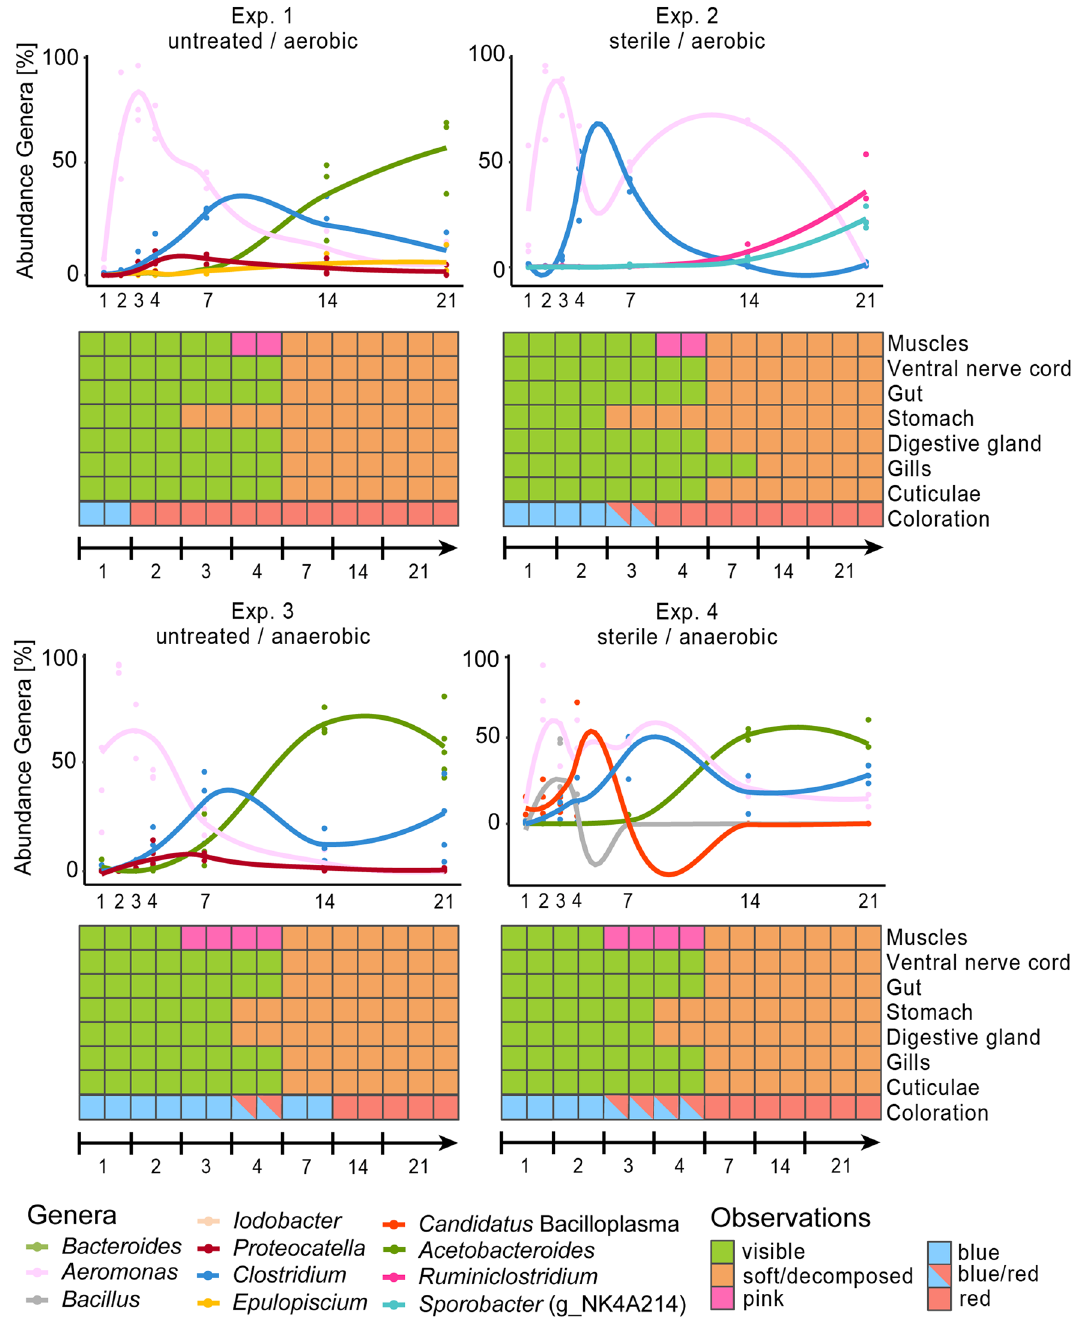
Figure 2. Time-dependent abundance of dominant genera and optical decay of body areas and inner organs of decaying crayfish for a duration of 21 days at 24